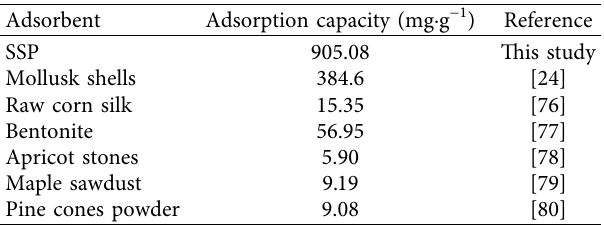
Table 5: Comparison of Cu(II) adsorption studies using various